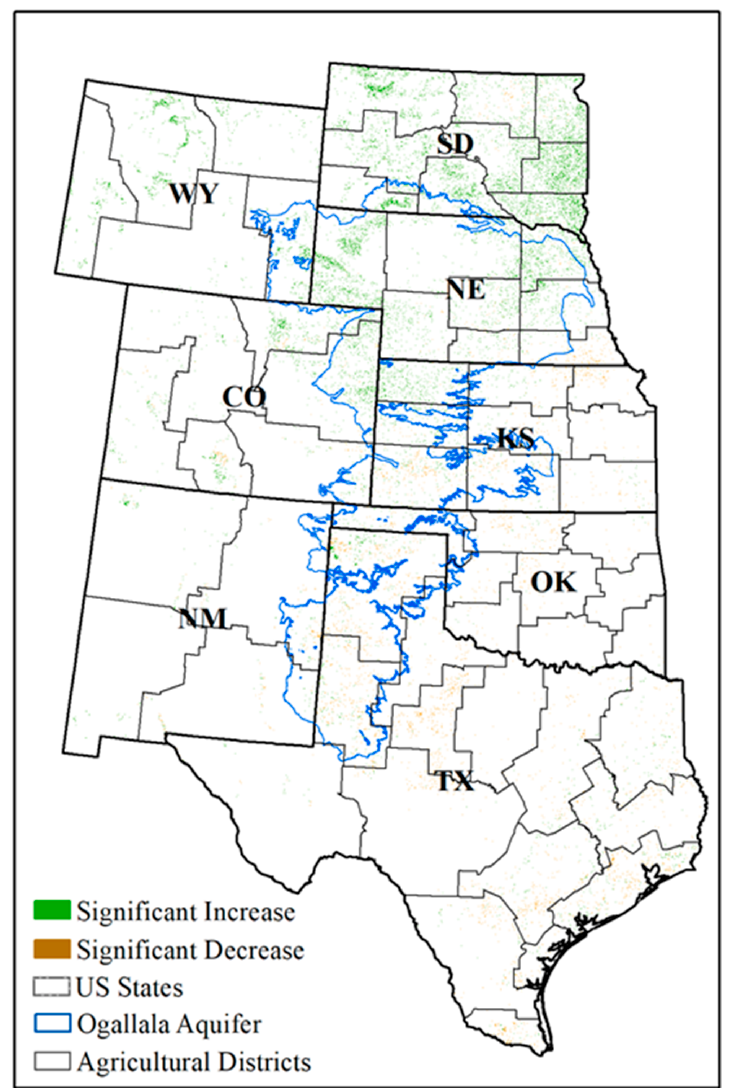
Figure 5. Net primary production (NPP) positive and negative significant trends for the period 2001 to 2018. (Forest and grassland are masked to better relate NPP to agriculture).